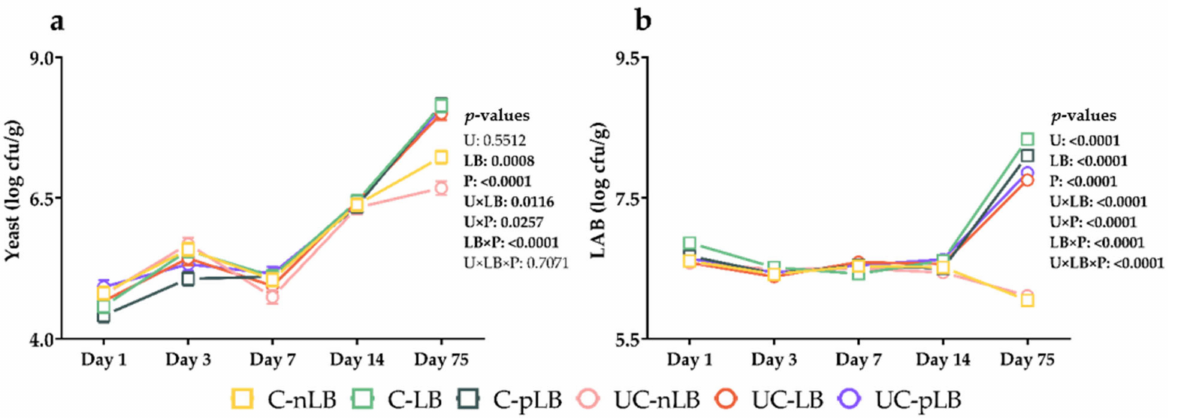
Figure 5. Effect of the ensiling length, the treatment with urea, and preactivation of L. buchneri on microbial count. Changes in yeast ( a ), and lactic acid bacteria [LAB, ( b )] content of corn silage. C: corn silages not treated with urea, UC: corn silages treated with 1.0% urea on dry matter basis, C-nLB: corn silages not treated with urea and uninoculated with L. buchneri , C-LB: corn silages not treated with urea and inoculated with L. buchneri , C-pLB: corn silages not treated with urea and inoculated with preactivated L. buchneri , UC-nLB: corn silages treated with urea and uninoculated with L. buchneri , UC-LB: corn silages treated with urea and inoculated with L. buchneri , UC-pLB: corn silages treated with urea and inoculated with preactivated L. buchneri . Factors that are statistically significant are highlighted in bold ( p <